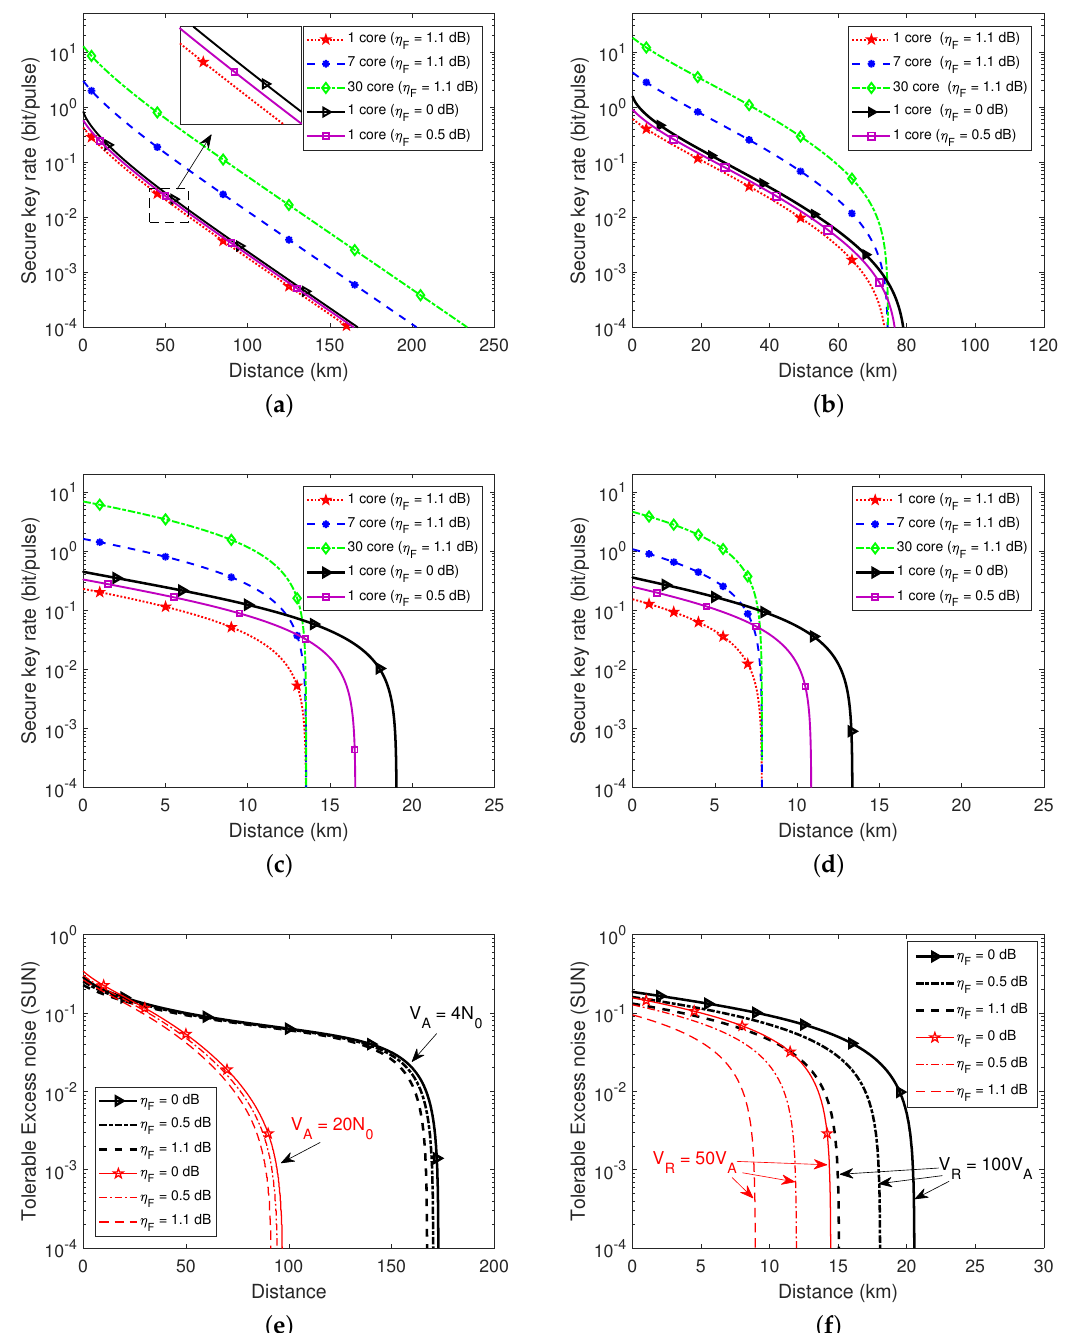
Figure 5. The secret key rate and the tolerable excess noise of MCF-based one-way CVQKD protocols, when using different values of η F . ( a ) CVQKD with transmitted LO for V A = 4 N 0 . ( b ) CVQKD with transmitted LO for V A = 20 N 0 . ( c ) CVQKD with locally generated LO for V R = 100 V A . ( d ) CVQKD with locally generated LO for V R = 50 V A . ( e ) The tolerable excess noise for the transmitted LO scheme. ( f ) The tolerable excess noise for the locally generated LO scheme. V A is set to 40 N 0 for the locally generated LO scheme. In the results of secret key rate, the black lines are for the SMF-based system, the red dotted lines are for the one-core-based system, the blue lines are for the 7-core-based system and the green dash dotted lines are for the 30-core-based system, the violet solid lines are the results for the case of using SMF, i.e., η F = 0